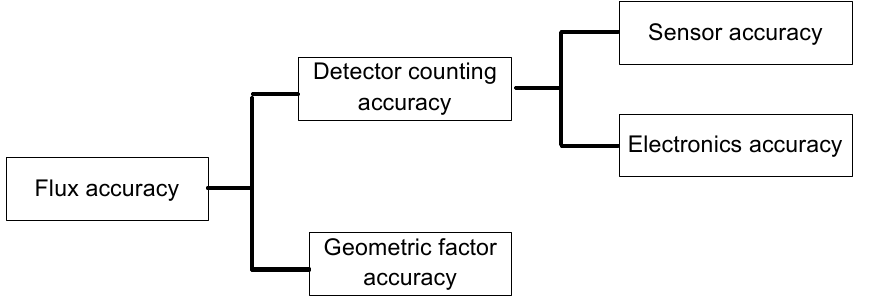
Figure 17. Influencing factors of flux calibration accuracy.